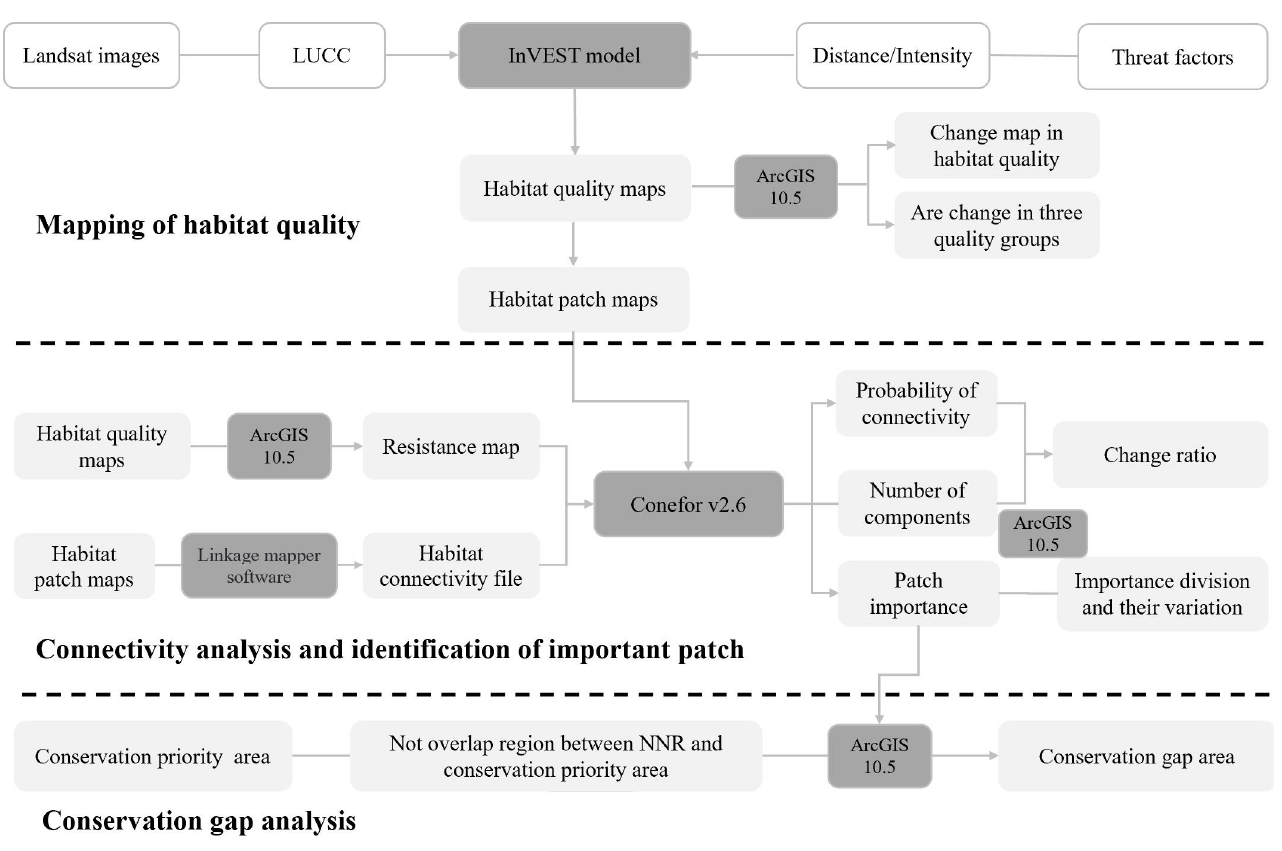
Figure 2. Methodological framework.